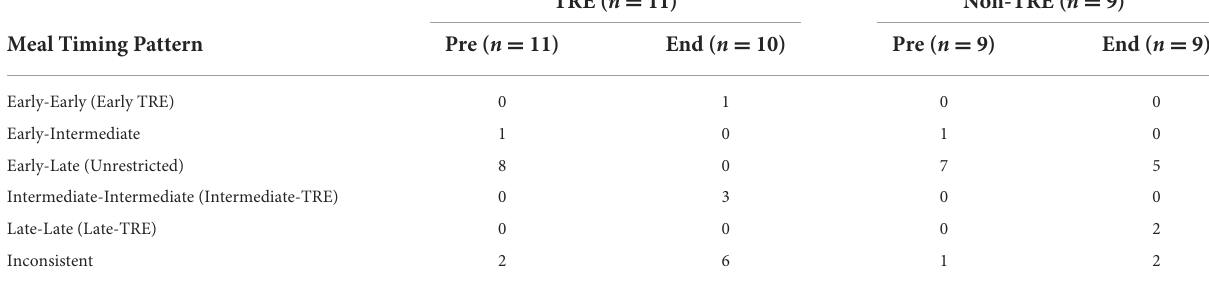
TABLE 2 Meal timing patterns.